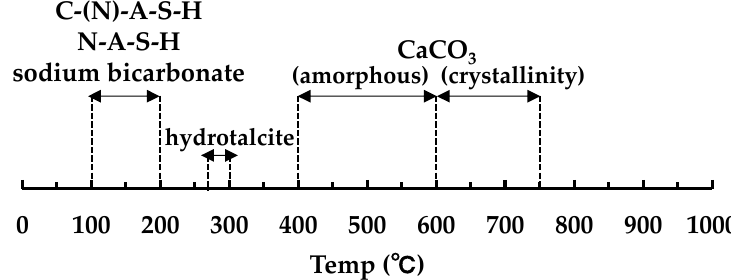
Figure 7. Decomposition temperature of hydrates and carbonates in TG/DTG .